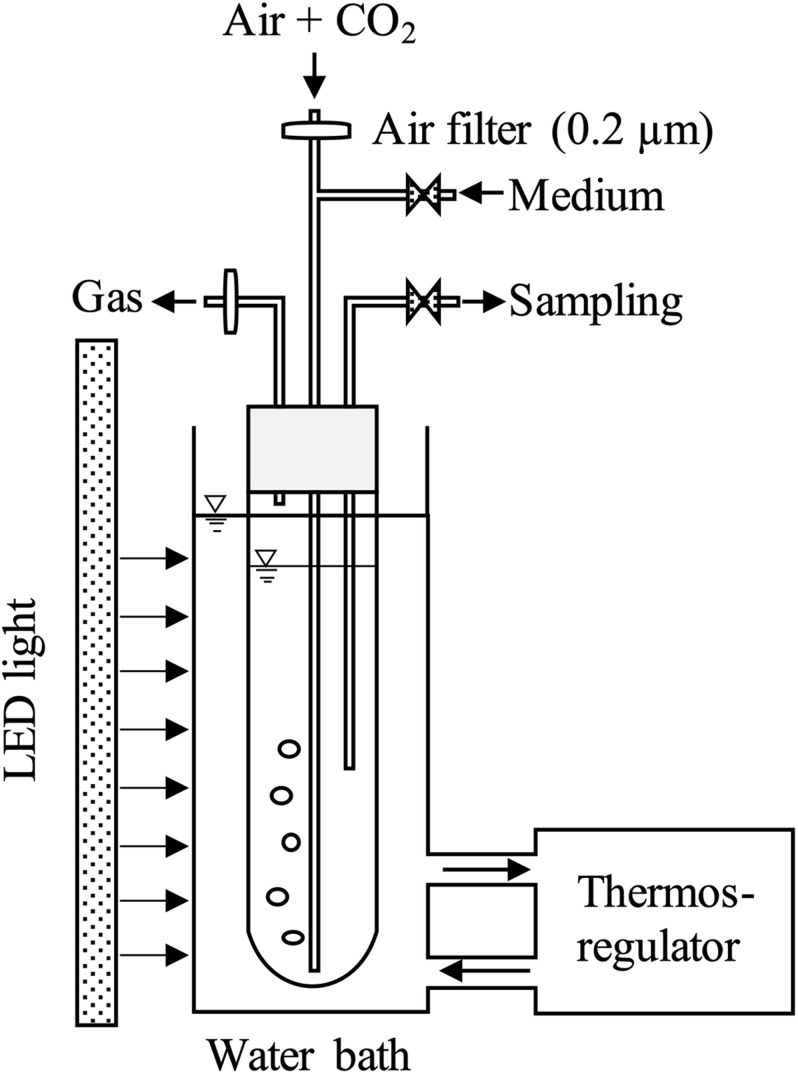
Schematic diagram of the column photobioreactor: inner diameter of 6.0 cm, working volume of 1.0 L. Light was provided to the surface of the water bath at 12L:12D. Filtered air (0.2 μm) was added with 2% CO2 from the bottom of the column reactor at a flow rate of 0.2 L min–1.